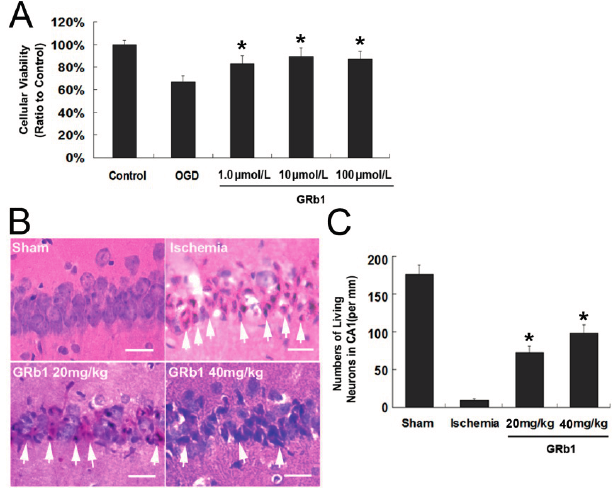
Figure 1. Protective effect of Ginsenoside Rb1 (GRb1) on both oxygen glucose deprivation (OGD)-induced cell death in SH-SY5Y cells and neuronal death in CA1 region caused by transient global ischemia. ( A ) MTT assay of cellular viability of SH-SY5Y cells. The reduction in the cellular viability at recovery 24 h following OGD treatment was counteracted by administration of GRb1; ( B ) Histological images of the CA1 neurons stained with hematoxylin and eosin 40×. The dead neurons indicated by arrows presented condensed polyglonal nuclei and pink cytosols; ( C ) Statistical analysis of living neurons in the CA1 region. Scale bar = 20 µm. * p < 0.01 versus OGD group. Each experiment was performed four